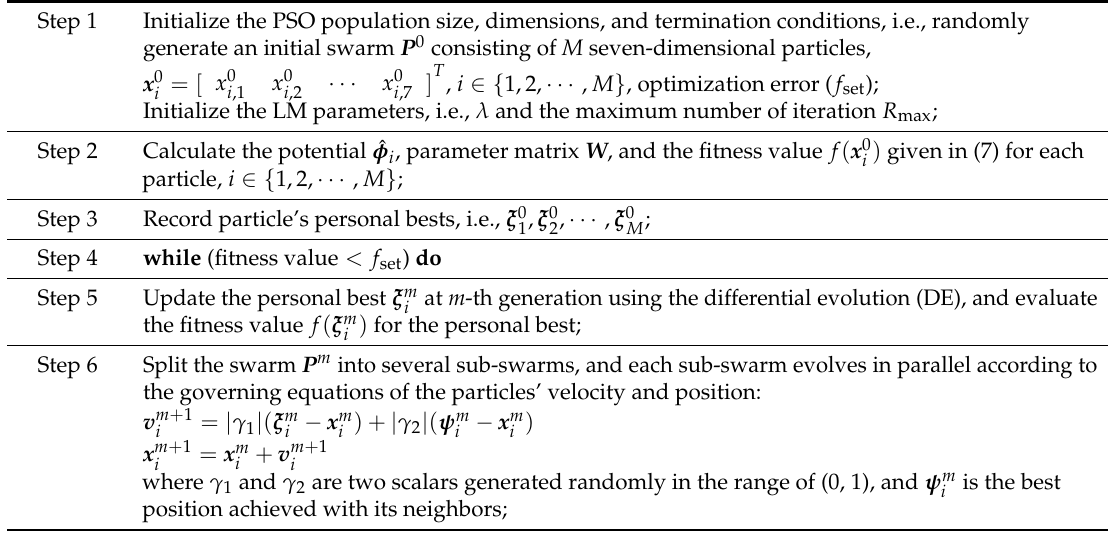
Table 1. Implementation of PSO-LM